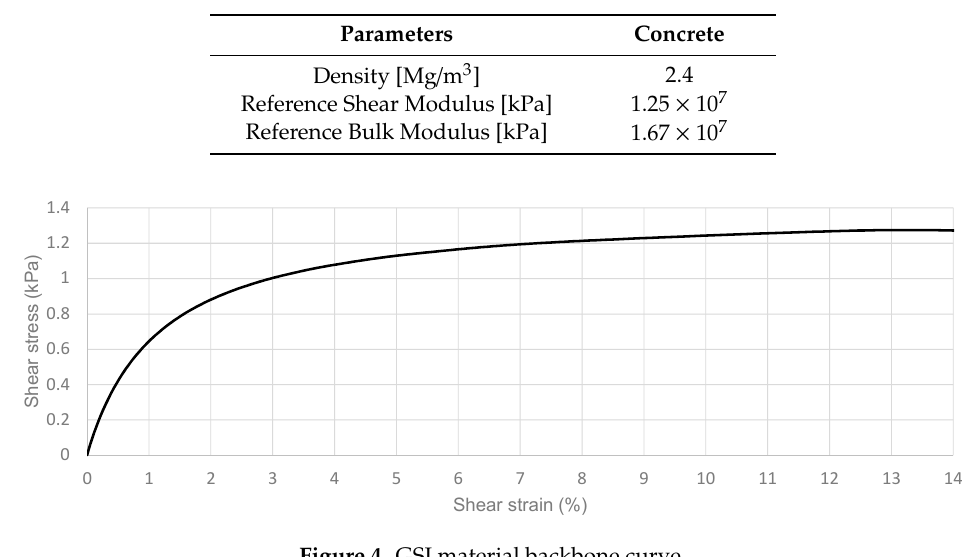
Table 4. Foundation.